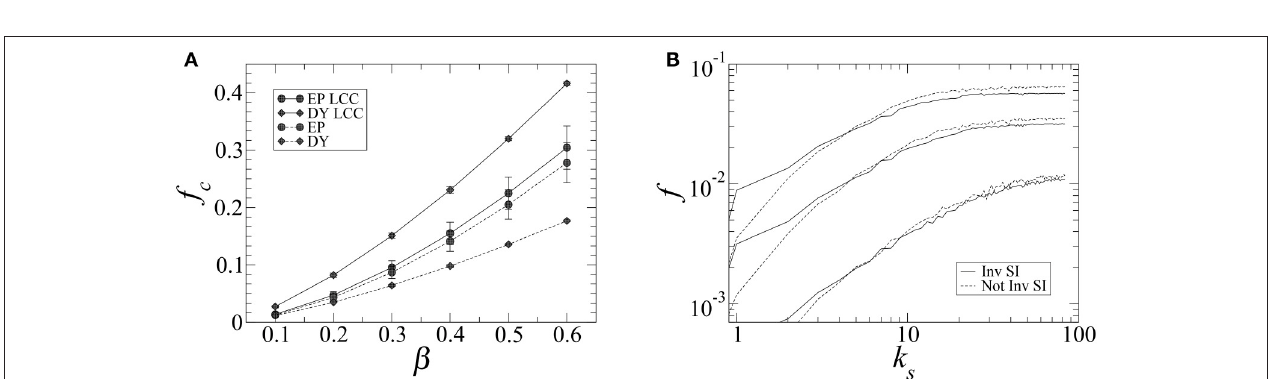
FIGURE 4 | Average fraction f of informed population by reviews created from users of different k-shells vs. the k-shell number ( k s ). The different curves show results for different probabilities β ∈ [0.1 , 0.6] , with the lower curves corresponding to smaller β ’s. Inset: Average fraction f of informed population by reviews created from users of the lowest (circle) and the highest (diamond) k-shell vs. probability of information transmission β . Left panel : DY. Right panel : EP.